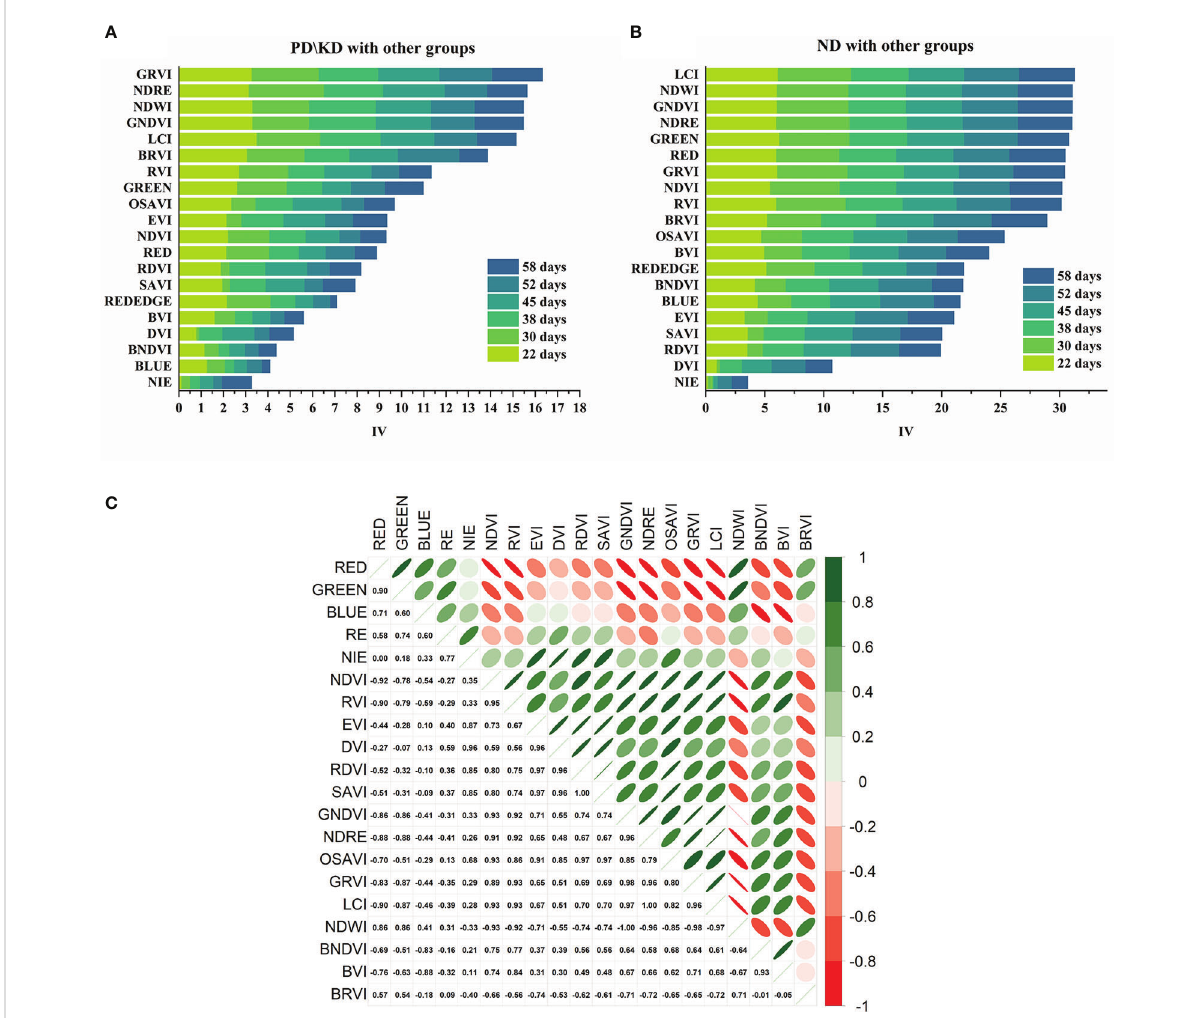
FIGURE 4 Variable screening based on IV and correlation. (A) The IV was calculated with PD\KD as the positive sample and the other treatment groups as the negative sample. (B) The IV was calculated with the ND as the positive sample and the other treatment groups as the negative sample. (C) Heat map of vegetation index